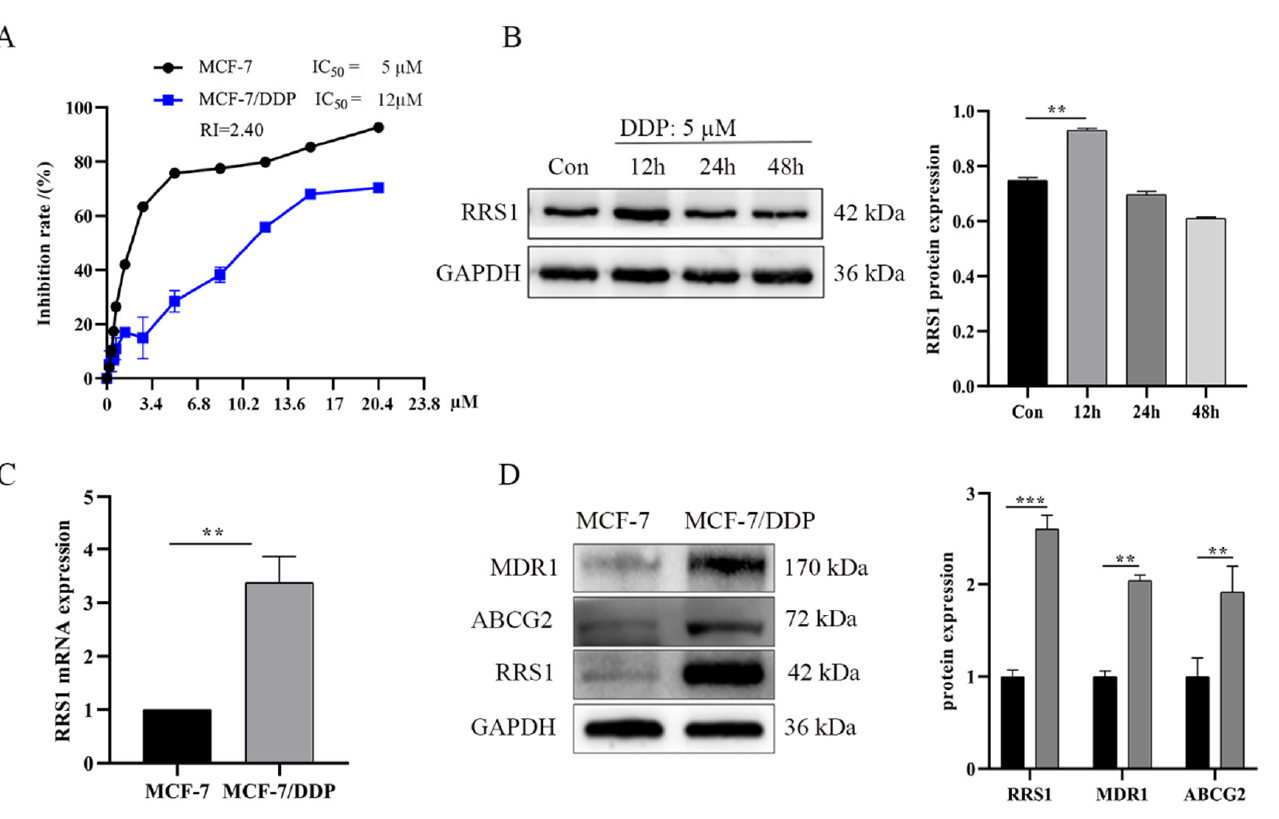
Figure 1. Identification of the drug resistant cell MCF-7/DDP cell line and RRS1 expression. ( A ) IC 50 of DDP for MCF-7 and MCF-7/DDP cells. ( B ) MCF-7 cells were treated with it IC 50 of cisplatin at 12 h, 24 h and 48 h; RRS1 protein expression was measured. ( C ) RRS1 mRNA levels in the indicated cell lines. ( D ) Immunoblot showing RRS1, ABCG2 and MDR1 protein levels in the indicated cell lines. Data are expressed as mean ± SD of at least three independent experiments. ** p < 0.01, *** p < 0.001. RRS1, human regulator of ribosome synthesis 1; ABCG2, ATP-binding cassette sub-family G member 2; MDR1, multidrug resistance protein 1.